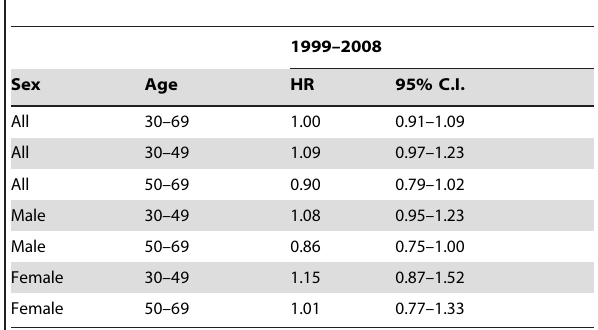
Table 9. Cox model for 10-year observation period. Table 7. Standard Bootstrap with 100 re-samples for the two